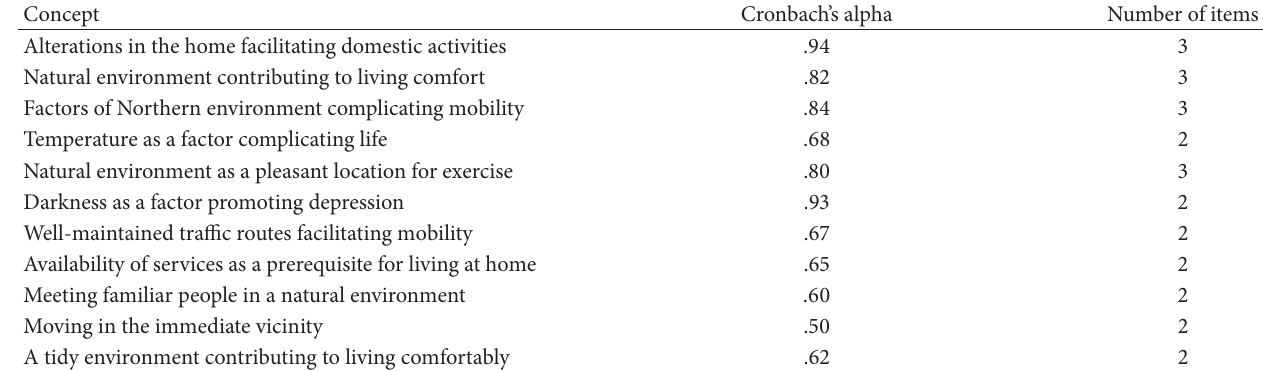
Table 1: Names, alpha values, and number of items of the concepts describing physical environment (𝑛 = 328) .